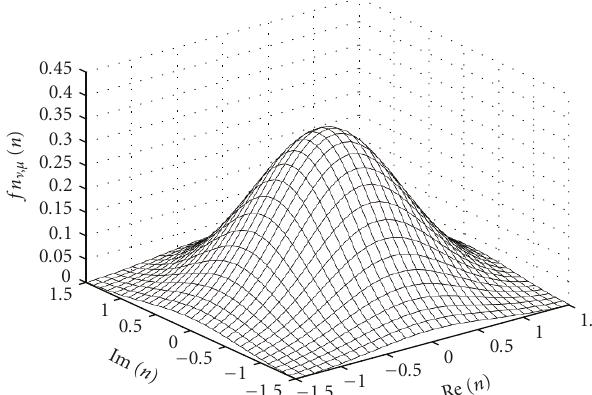
Figure 5: Hybrid pdf approximation of ISI, MAI, and noise for ( E b / N 0 ) = 25 dB with t (cid:2) = 10log 10